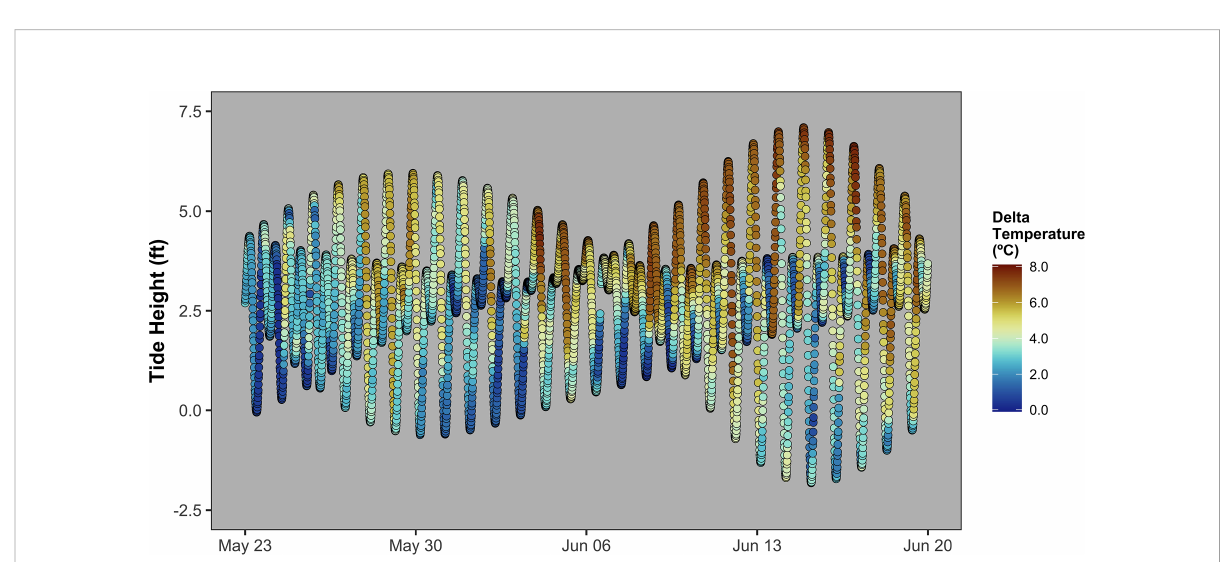
FIGURE 5 Tide height over an example lunar month (2022 May 23 – 2022 June 20), colored the difference between sea surface temperature and sea fl oor temperature.